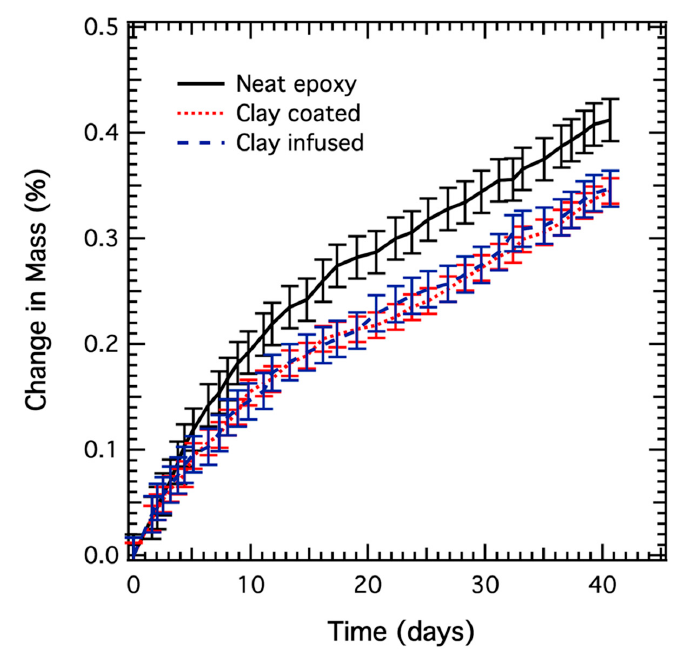
Figure 6. Change in the mass of carpet composites due to alternating environmental exposure.